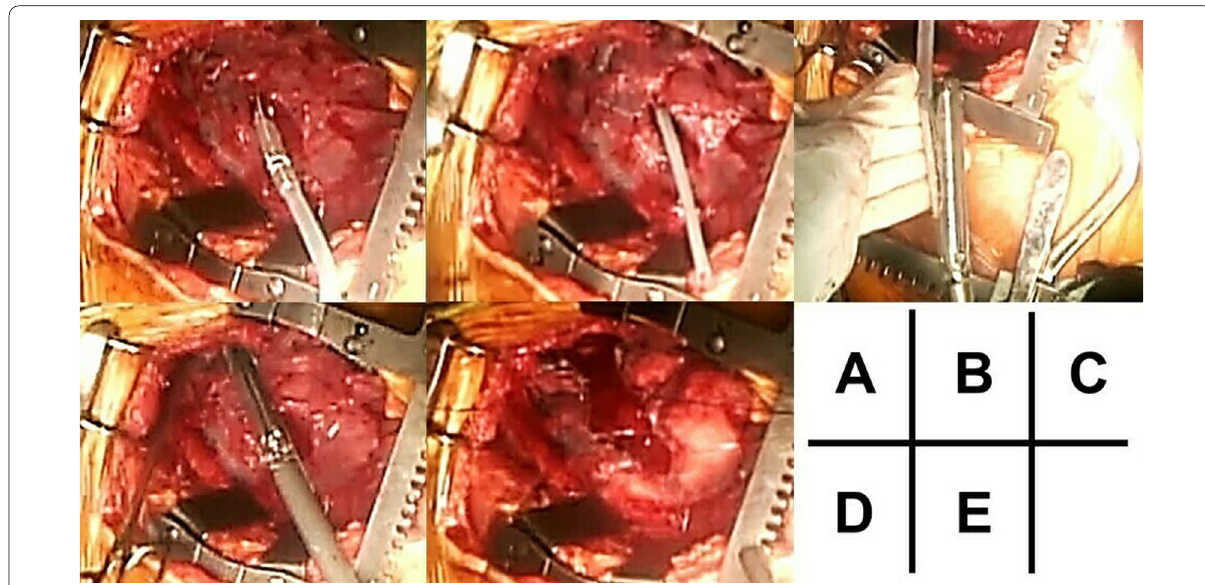
Fig. 4 Procedure (surgical image): A the Penrose drain is fixed to the chest tube, which is removed; B the Penrose drain is seen fully penetrating the lung. C The Penrose drain was attached to the stapler, D which was guided into the wound tract. E Stapling made the wound tract